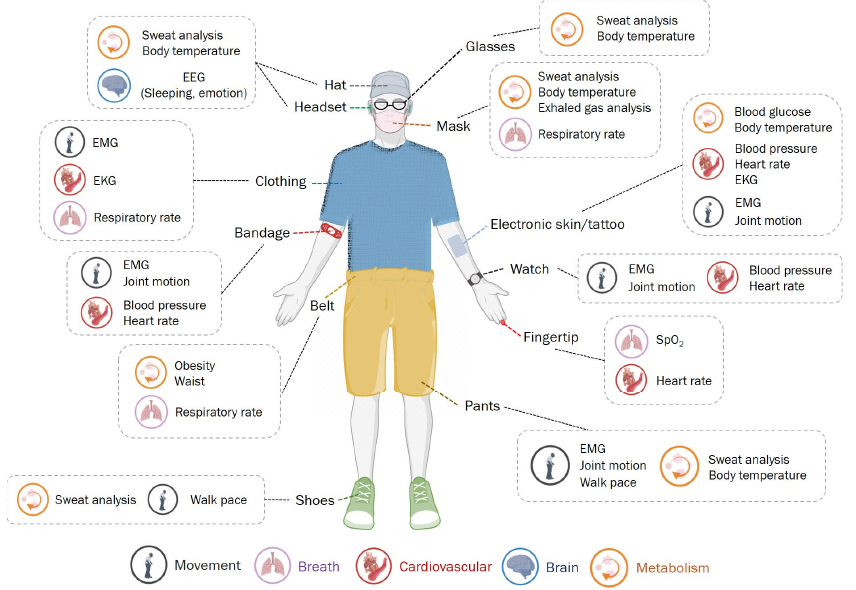
Figure 1. Scheme of detectable bio-signals on human body and their wearable detections (categorized by different part of human body and different systems that signals belong to) where the electrical activity signals that electrocardiography, electromyography, and electroencephalography are abbreviated as ECG (electrocardiogram) (or EKG), EMG (electromyography) and EEG (electroencephalogram).